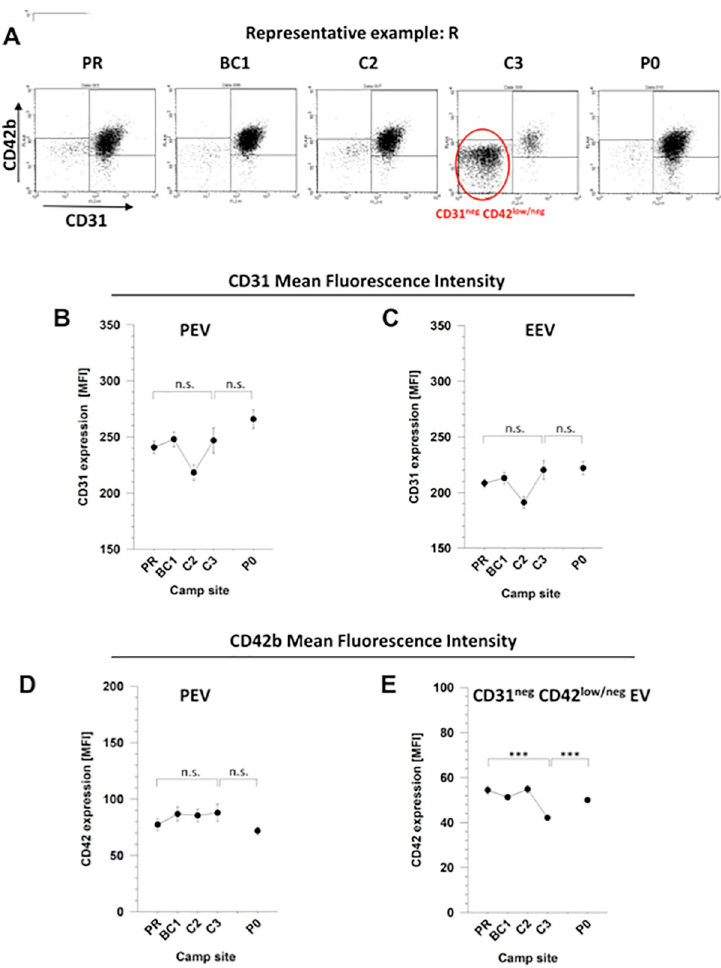
Fig 2. Expression levels of CD31 and CD42b on AnnexinV pos extracellular vesicles. Plasma samples of mountaineers were analysed by flow cytometry as specified in Fig 1. Expression levels of the markers CD31 and CD42b were determined as mean fluorescence intensity (MFI). (A) Dot plots of expression levels of CD31 and CD42b on AnnV pos EV of a representative individual (“R”) are shown at each altitude. The emergence of a large amount of CD31 neg CD42b low/neg EV at C3 is highlighted. (B-C) Expression levels of CD31 on PEV (B) and EEV (C). (D-E) Expression levels of CD42b on PEV (D) and CD31 neg CD42b low/neg EV (E). Shown are means +/- SE of data from all individuals reaching the indicated camp sites. Statistical significance of p < 0.001 is indicated by “ ��� ”; “n.s.” = not